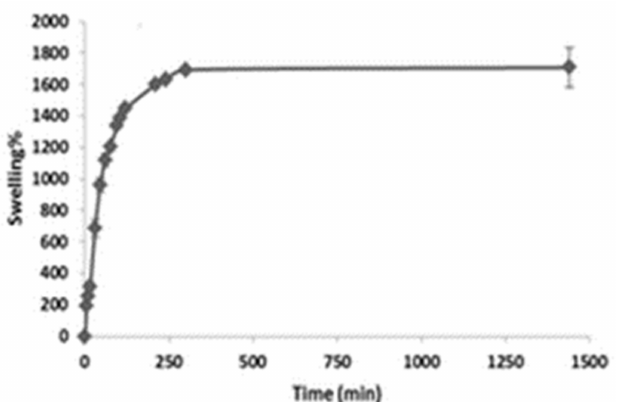
Figure 14. Swelling curve for crosslinked hydrogel films prepared from aqueous blends containing 20% w / w PMVE/MA, 7.5% w / w PEG and 3% Na 2 CO 3 based on the increasing mass of the swelling array expressed as a percentage of the mass of a dry array (Means ± SD, n = 3). Adapted from ref